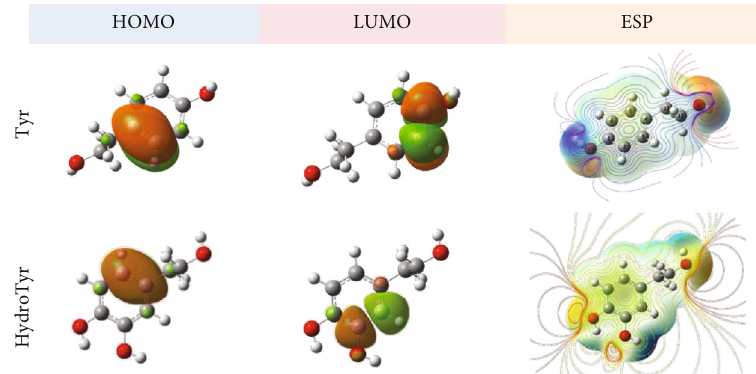
Figure 8: Isosurface of frontier molecular orbitals (i.e., HOMO and LUMO) and ESP map (red (blue) color refers to negative (positive) potential) of Tyr and HydroTyr molecules.